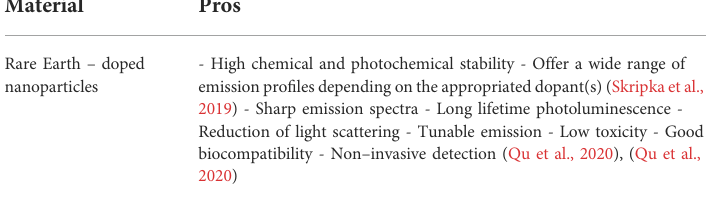
TABLE 2 Advantages and disadvantages of RE – doped nanoparticles for application in PDT.